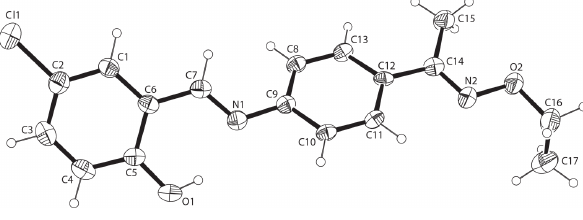
Table 1: Data collection and handling.